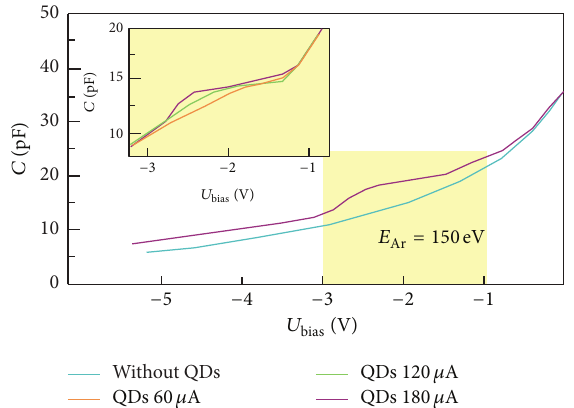
Figure 13: Capacitance-voltage characteristics.